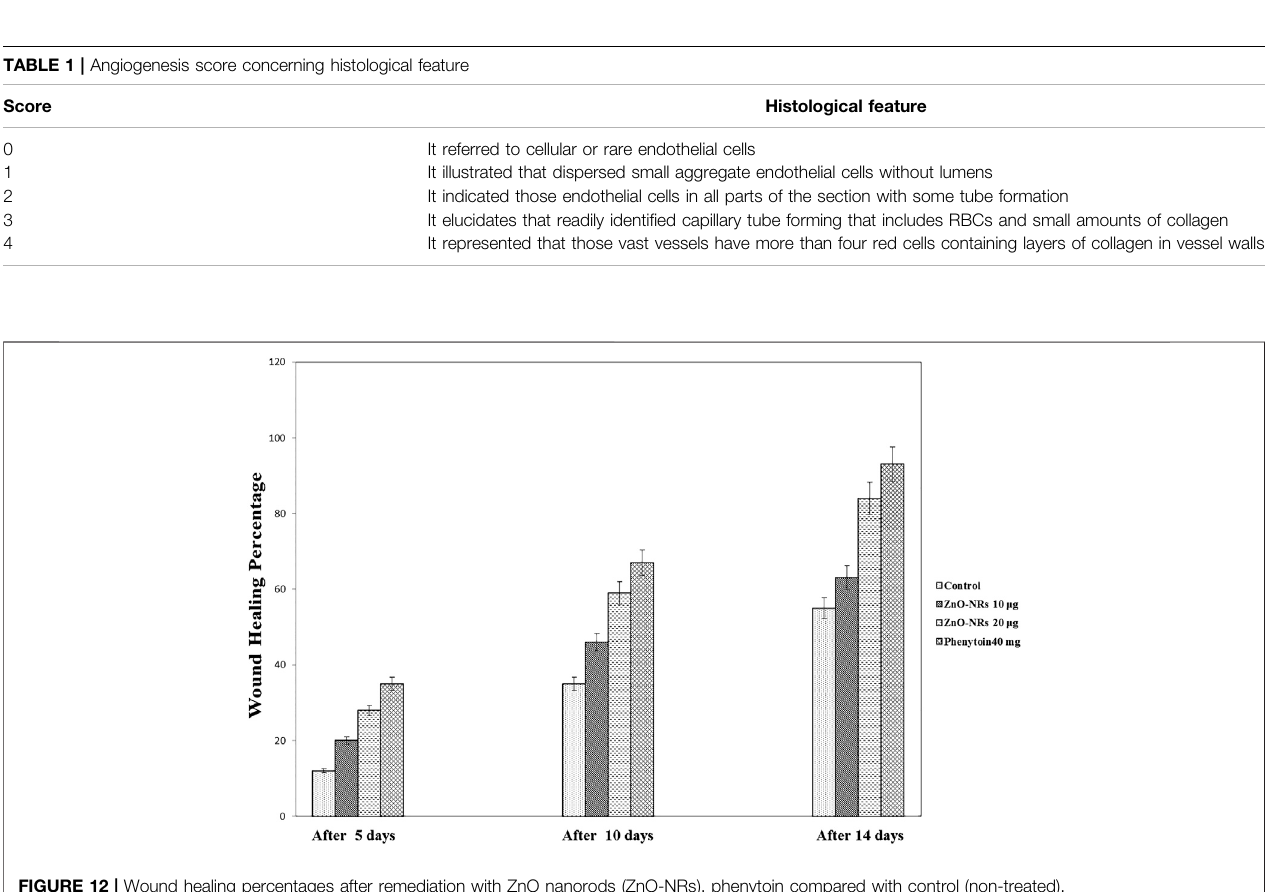
FIGURE 12 | Wound healing percentages after remediation with ZnO nanorods (ZnO-NRs), phenytoin compared with control (non-treated).